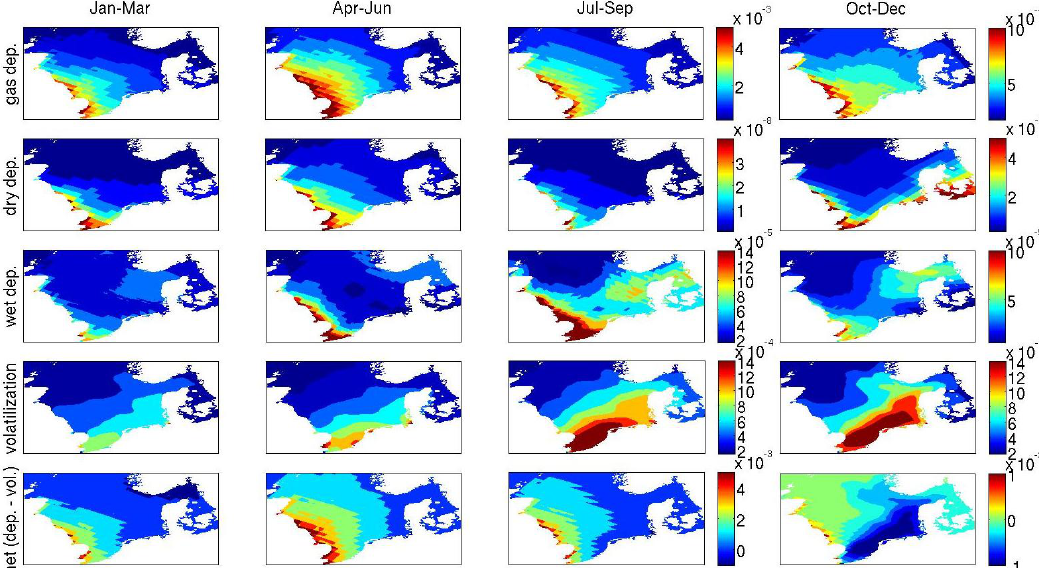
Figure 3. Distributions of quarterly (3 month) averaged rates of gas deposition ( top row ), dry deposition ( 2nd row ), wet deposition ( 3rd row ), volatilization ( 4th row ), and net air-sea exchange ( bottom row ) for γ-HCH in 2000. Rates are in (ng∙m −2 ∙s −1 ). Note: colorbar scales shown on 3rd column panels are used in connection with the left 3 panels. Note the change in scales for autumn (right figures), which are reduced relative to winter, spring and summer. Scales vary from row to row.